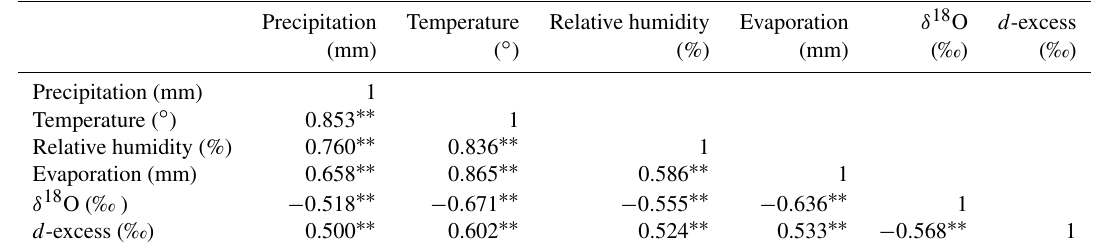
Table 1. The correlation analysis of δ 18 O and d -excess and meteorological factors in the fixed point (TTH and ZMD) from 16 March to 18 July.